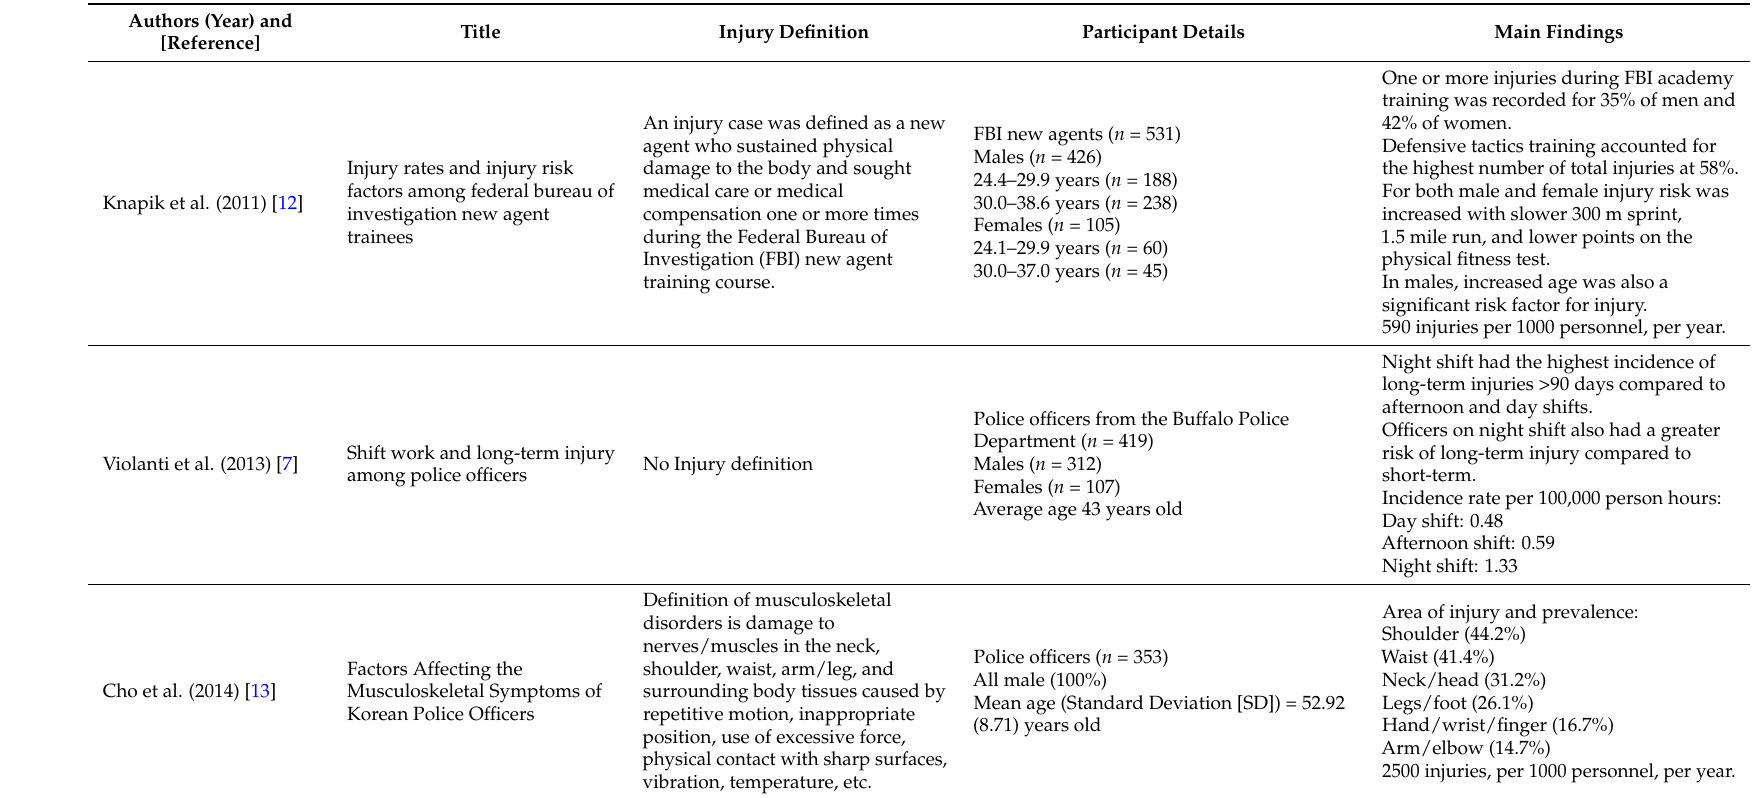
Table 5. Injury definitions, participants and main findings from each included